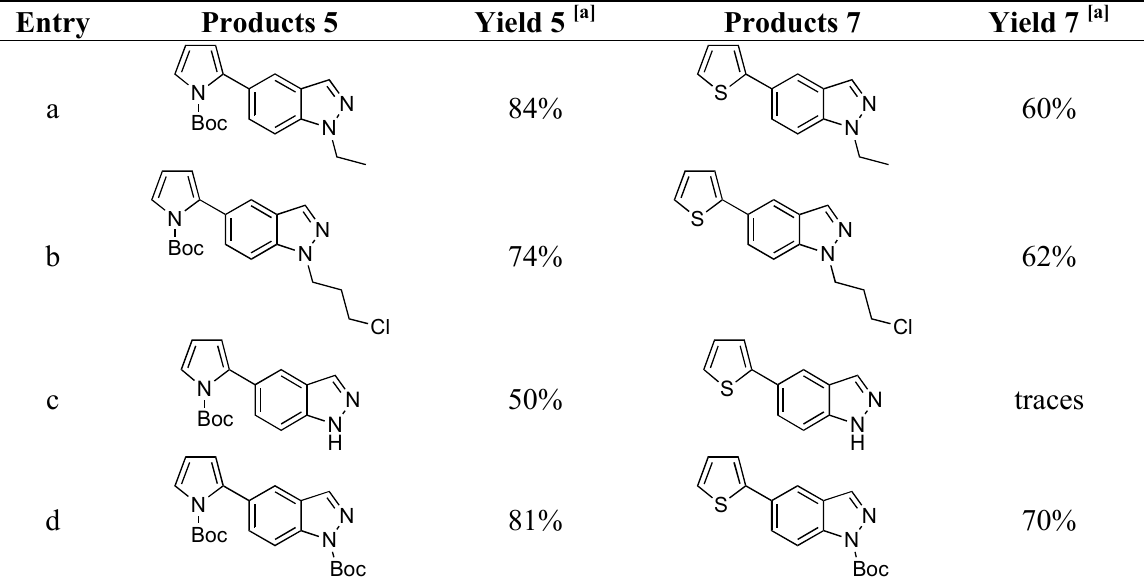
Table 2. Suziki cross-coupling reaction for the synthesis of 5-(pyrrol-2-yl)- and 5-(thiophen-2-yl)-1 H